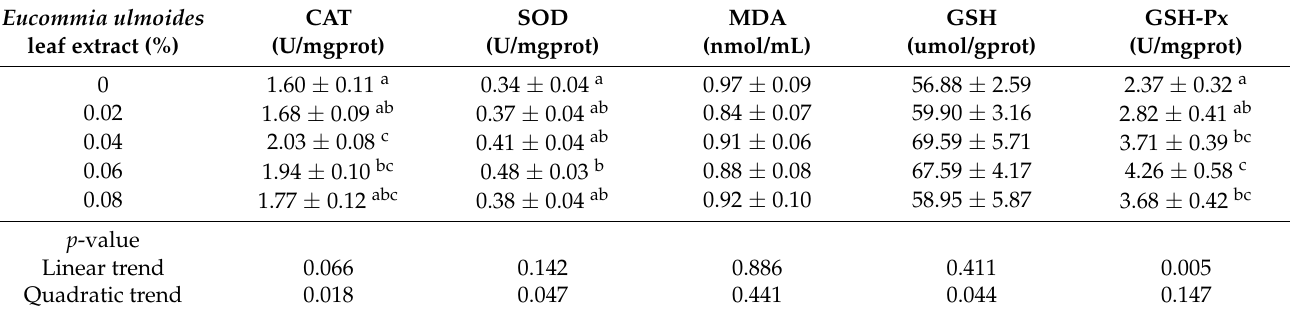
Table 7. Intestinal antioxidant enzyme activities of the GIFT fed with different diets.